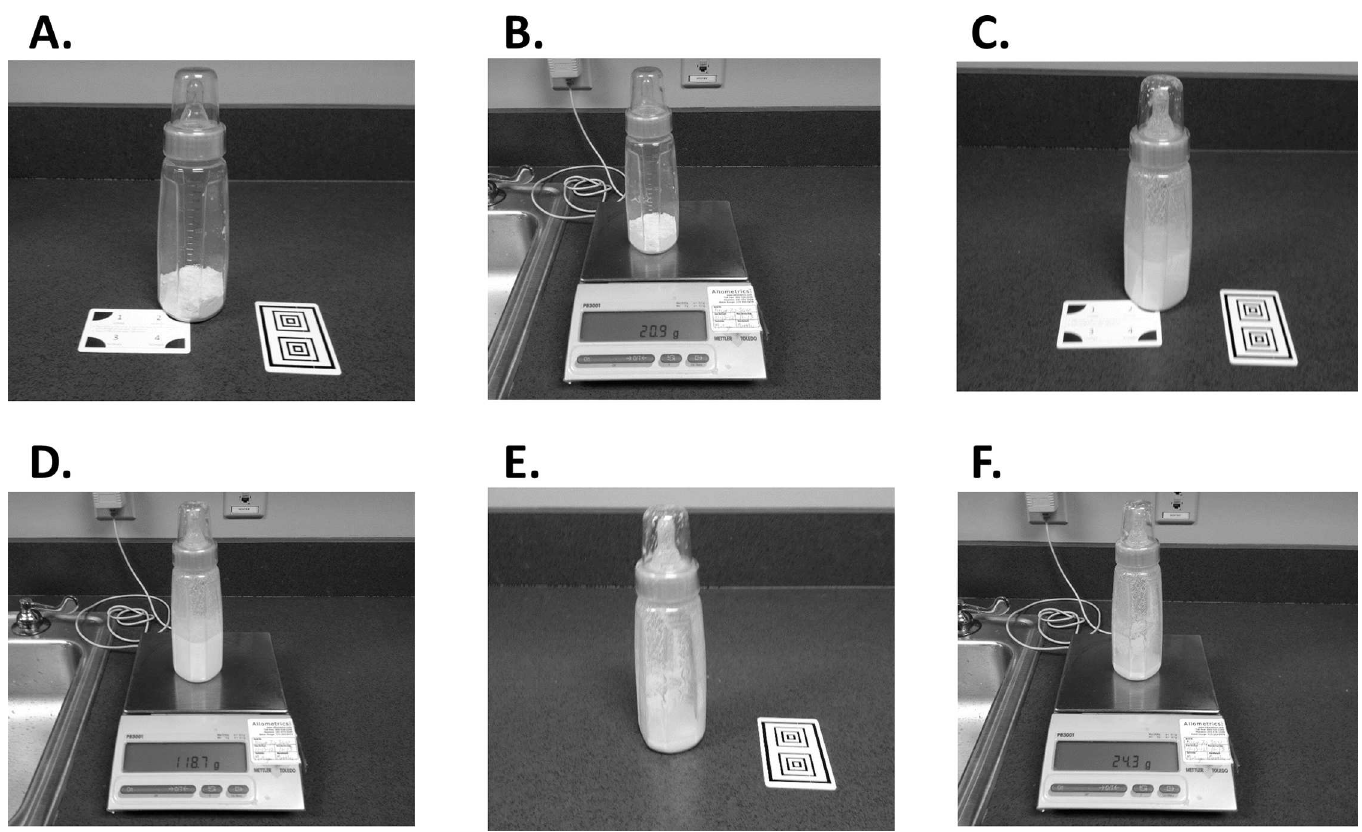
Fig 3. Infant Formula Preparation and Data Collection